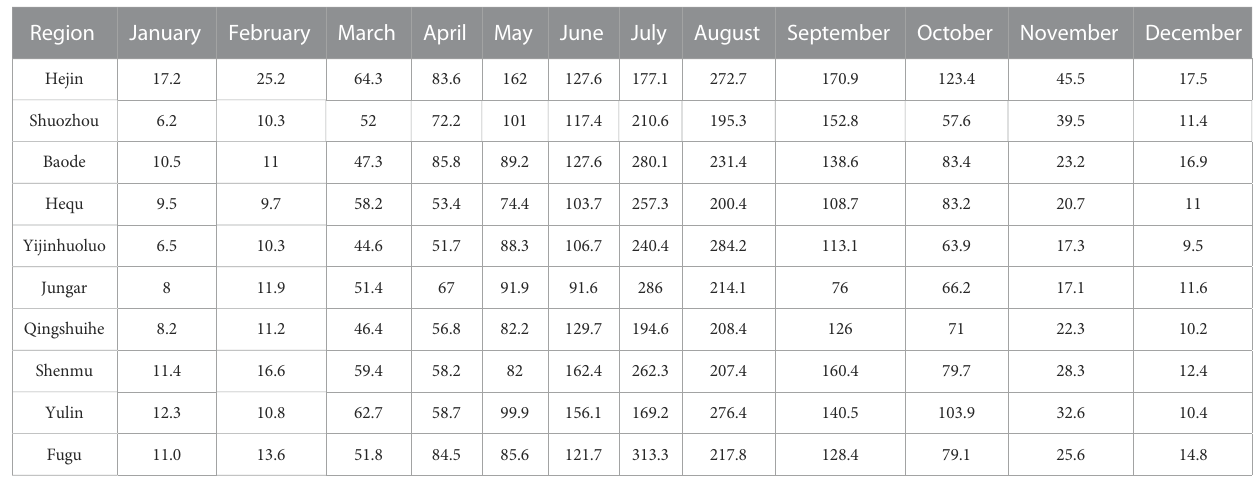
TABLE 1 Precipitation statistics of some cities in the study area.